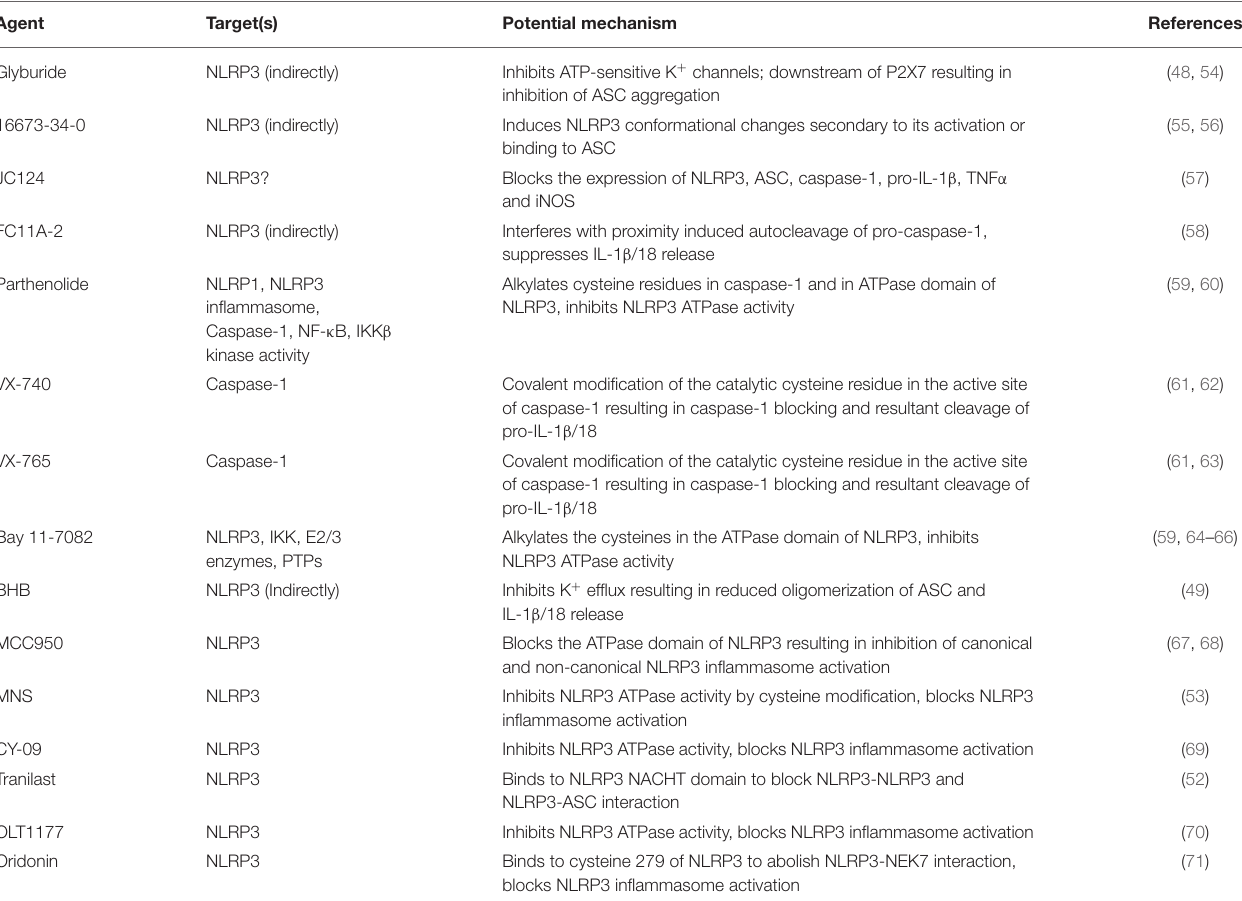
TABLE 1 | Potential inhibitors of NLRP3 inflammasome and their targets.